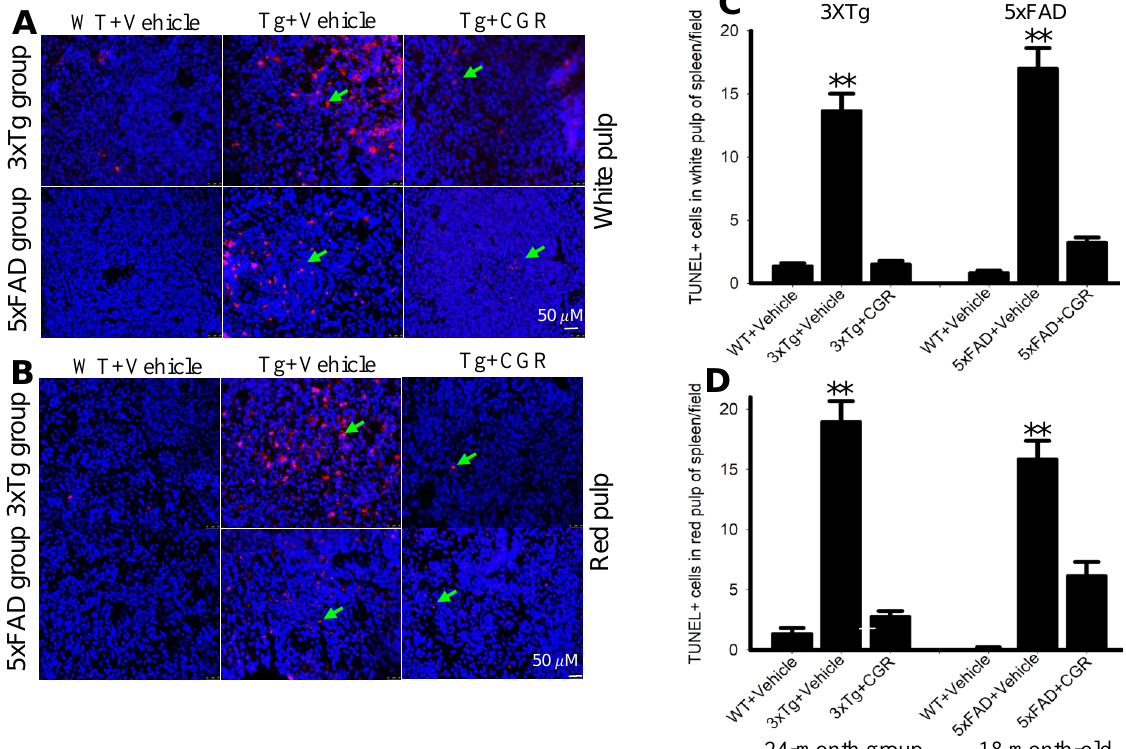
Figure 8. Number of TUNEL-positive cells was decreased in spleen by CGR treatment in both 3xTg and 5xFAD mice . After treatment with CGR (100 mg/kg) for 2 months, WT, 3xTg, and 5xFAD mice were perfused with PBS and fixed with 4% paraformaldehyde and in the spleens were dissected out, embedded with paraffin, and sectioned at 5 µ m. The TUNEL assay was performed to detect DNA fragmented/apoptosis death of these tissues, followed by DAPI, as a counterstain, with images taken using a fluorescent microscope with appropriate excitation/emission filters at a total magnification of 400 × . ( A , B ) Representative images of white pulp of spleen from 3xTg (24 months-old) and 5xFAD mice (18-month-old). ( C , D ) A significant increase in TUNEL-positive cells in white pulp (green arrows) of 3xTg+Vehicle-treated ( C ) and in 5xFAD+Vehicle-treated mice ( D ) in in comparison to age-matched WT+Vehicle-treated mice, whereas CGR treatment significantly reduced the number of TUNEL-positive cells. Red: TUNEL-positive cells, blue: DAPI (nuclei). Scale bar = 50 µ m and is applicable to all other images. ** p < 0.01 in comparison to WT+Vehicle and 3xTg+CGR-treated mice. Blue= DAPI, Red= TUNEL-positive